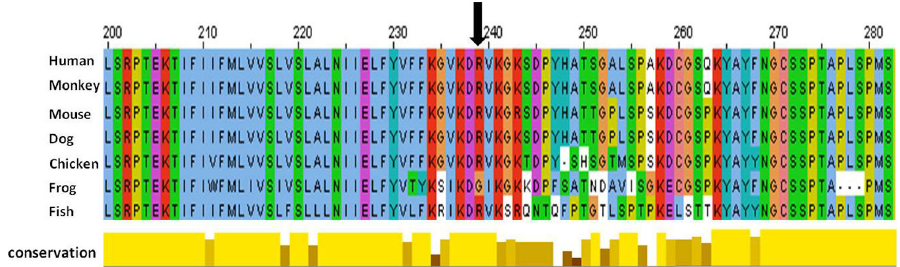
Figure 3. Phylogenetic comparison of GJA1 across species. Position of the mutation within a highly conserved region indicated with arrow.